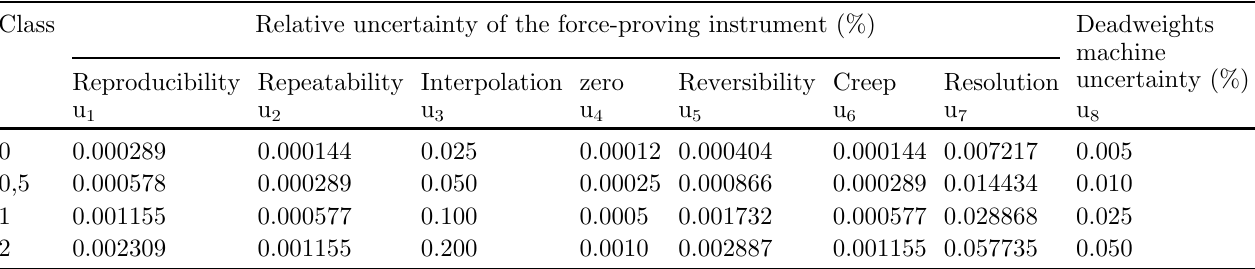
Table 2. Uncertainty components evaluation utilized for the proposed approach.